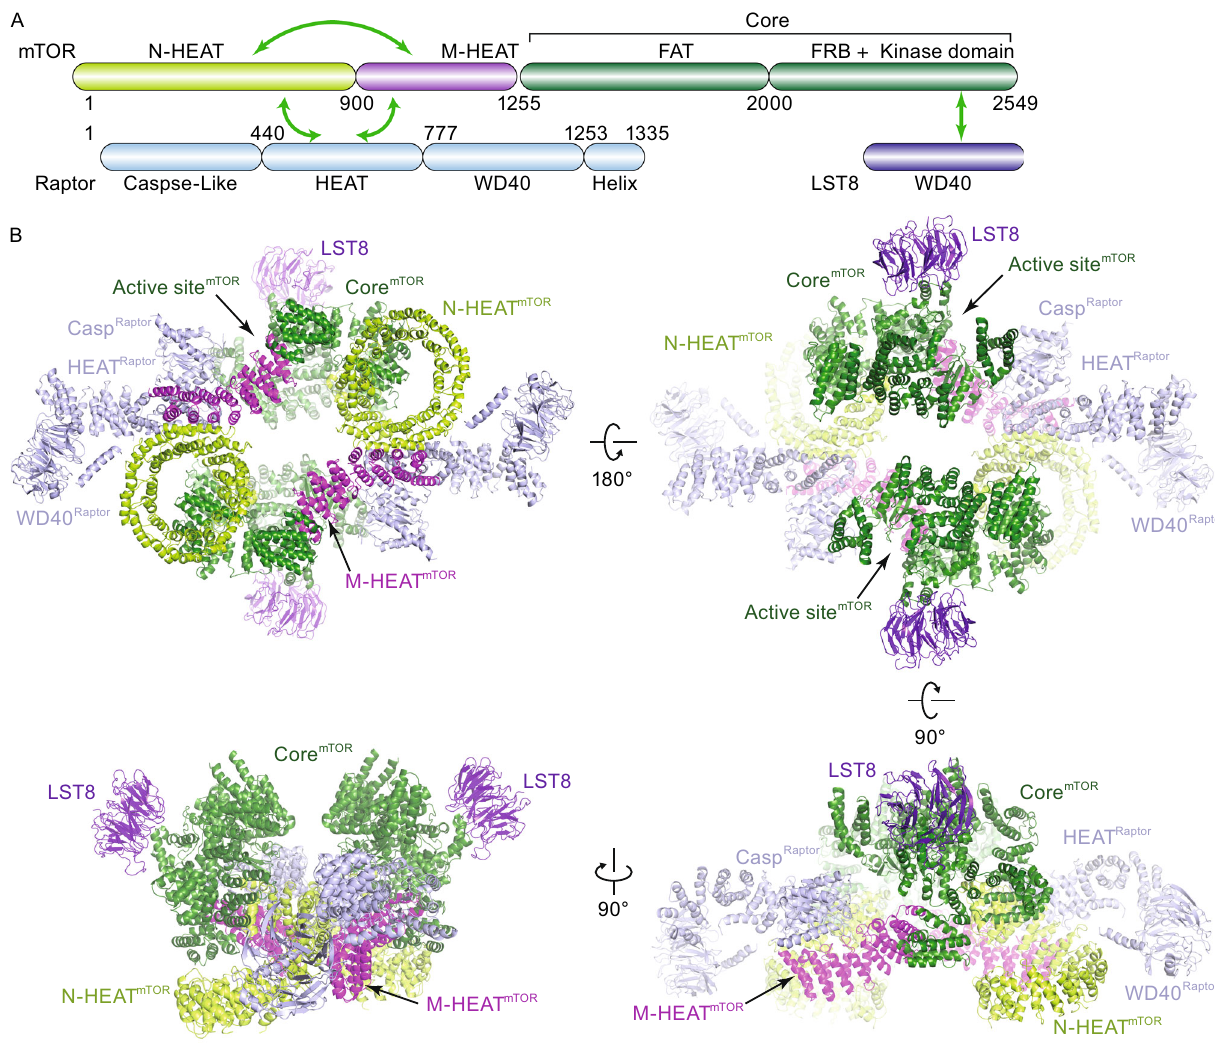
Figure 2. Overall structure of human mTORC1. (A) Colored coded domain architecture of the three essential components of human mTORC1. The same color scheme is used in all structure fi gures. The inter- and intramolecular interactions are indicated as arrows. B) Ribbon representation of mTORC1 structure in four different views. The proteins and domains are indicated. Casp Raptor represents Caspase-like domain of